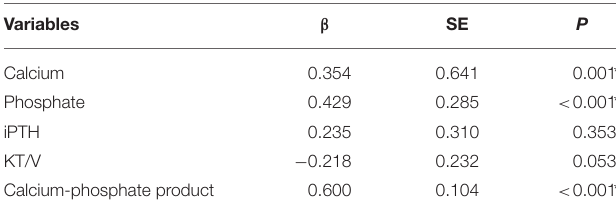
TABLE 3 | Univariate correlation analysis of FGF23 and other parameters. TABLE 4 | Multivariate regression analysis of regulatory factors of